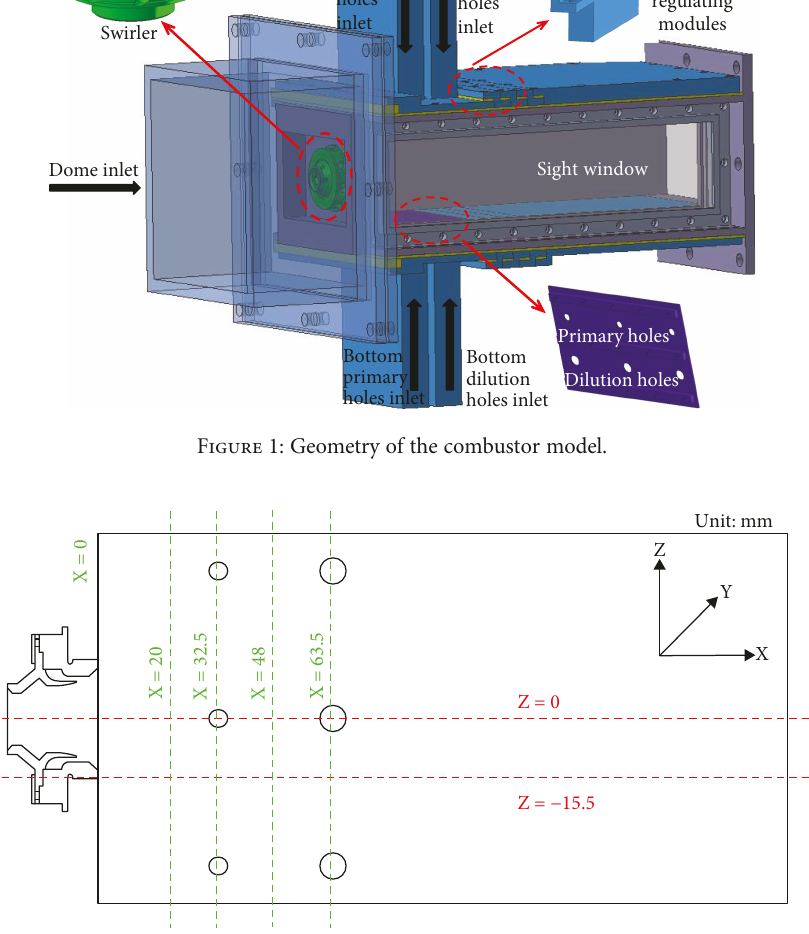
Figure 2: Sketch of the measurement plane for the PIV